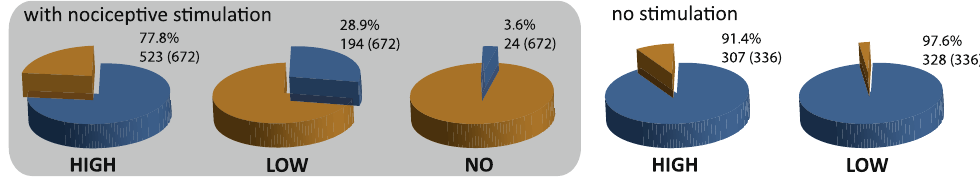
‘condition’ d = 0.36, t 893 = 5.34, p < 0.001). The more participants were willing to accept an electrocutaneous stim- ulus to receive money, the greater the perceived intensity increase or decrease of the electrocutaneous stimuli in the win trials (Fig. 3B). Condition effects of the moderator analysis showed that for individuals with below average values (mean – 1 std = 4.71) of the utility index, i.e. individuals who preferred to avoid pain at the cost of not getting a mone- tary win, the different conditions had no modulatory effect on the perception of the electrocutaneous stimulus (d = 0.07, t 893 = 1.12, p = 0.264). In contrast, with average (mean = 6.02) and above average (mean + 1 std = 7.32) utility index values, the tendency of a participant to accept money albeit being coupled to receiving an electro- cutaneous stimulus had a modulatory effect on the perception of the stimulus (mean rank: d = 0.45, t 893 = 6.74, p < 0.001; mean + 1 std rank: d = 0.56, t 893 = 8.43, p < 0.001), with stronger modulation the stronger the partici- pant’s tendency to accept the win and the stimulus (Fig. 3B).